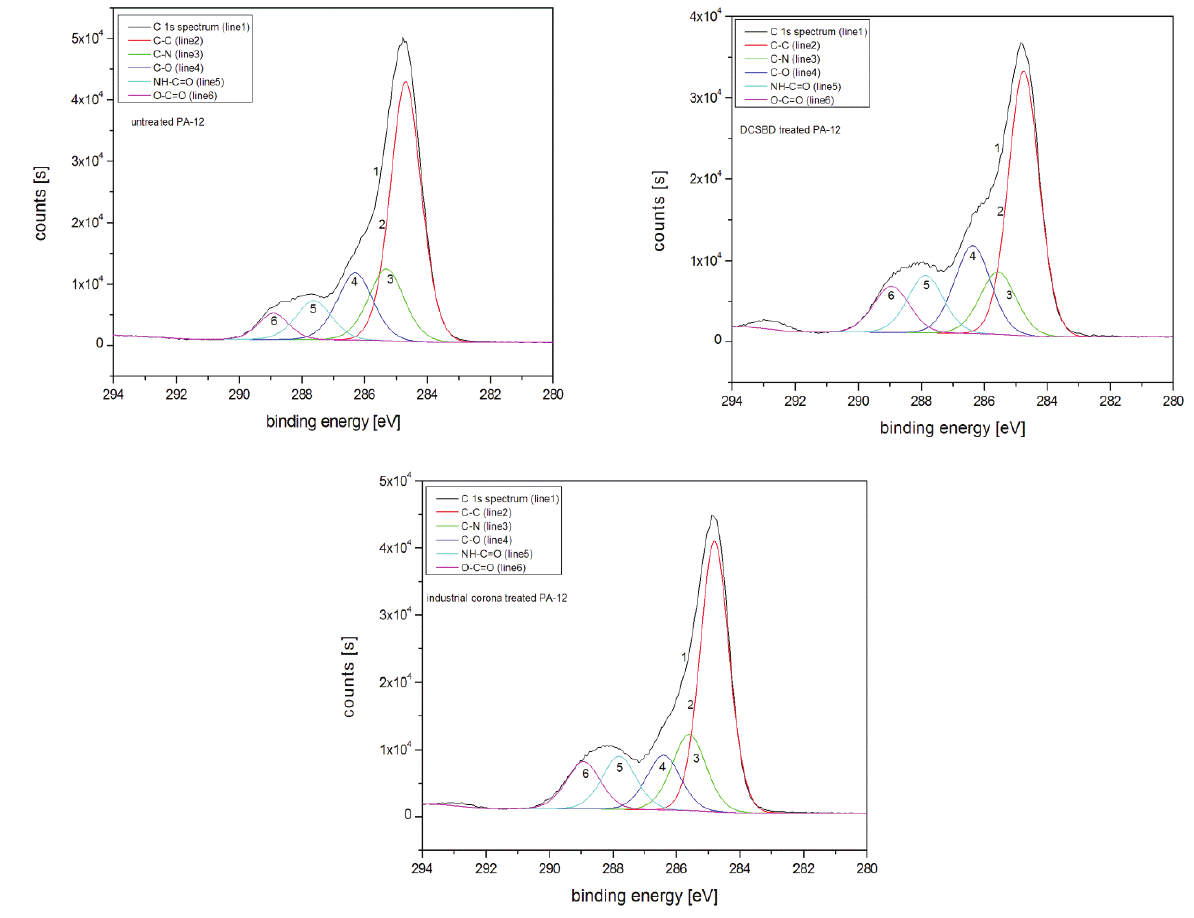
Figure 5: High resolution scans of C 1s of untreated, 15 s DCSBD treated and 15 s industrial corona treated